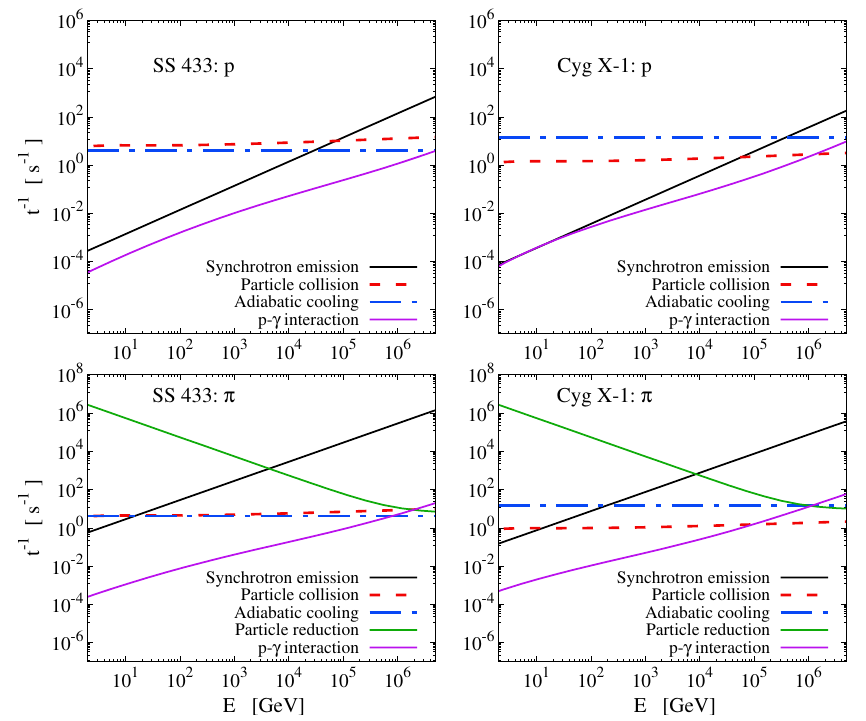
Figure 1. Cooling rates for relativistic protons and pions ( π ± ) produced at the base of the jet z 0 after the p-p and p- γ collision processes take place in SS 433 (first column) and Cygnus X-1 (second column). Those mechanisms include synchrotron emission (solid lines), particle collision (dashed lines), adiabatic cooling (dotted lines), p- γ interactions, as well as the particle reduction rate which includes the decay and escape rate of the particles (dotted-dashed